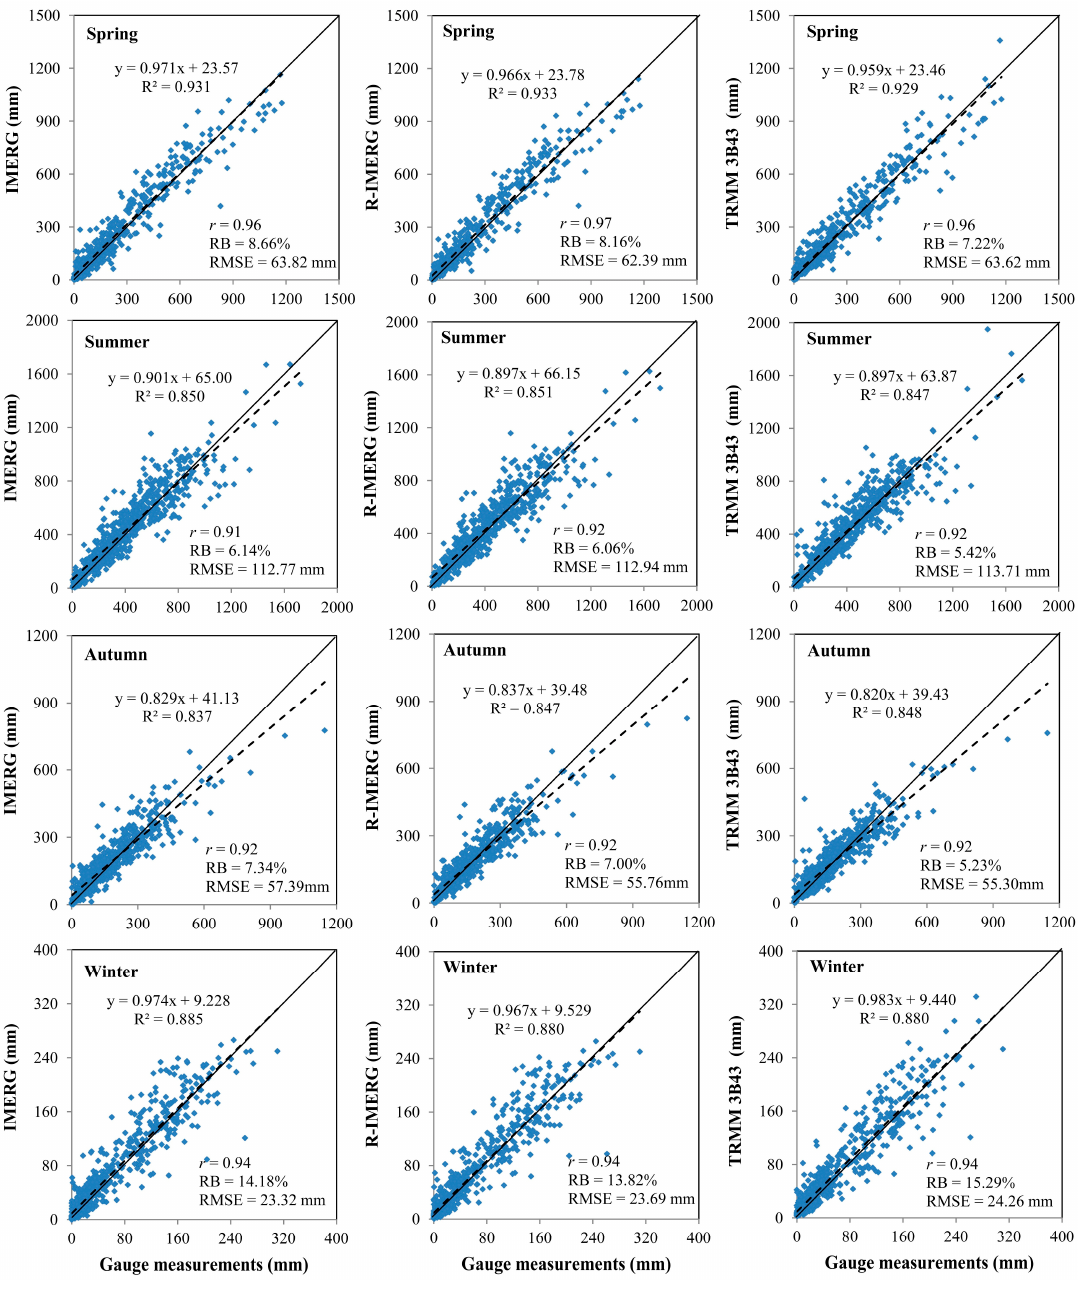
Figure 6. Scatter plots of gauge measurements versus seasonal precipitation estimates derived from IMERG, R-IMERG, and TRMM 3B43 products over Mainland China. IMERG, R-IMERG, and TRMM 3B43 products over Mainland